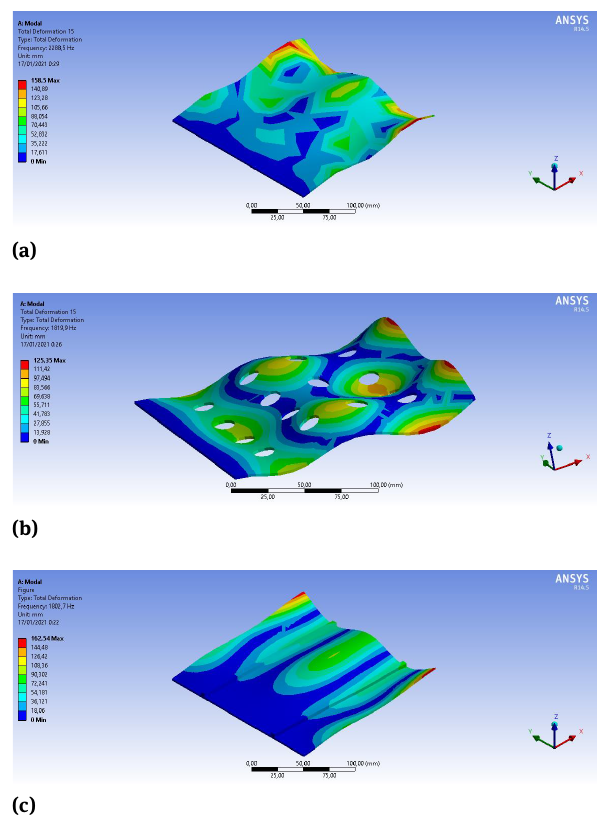
Figure 7: Total deformation contour of ice class materials: ( a ) virgin metal sheet; ( b ) hole metal sheet; ( c ) stiffener metal sheet